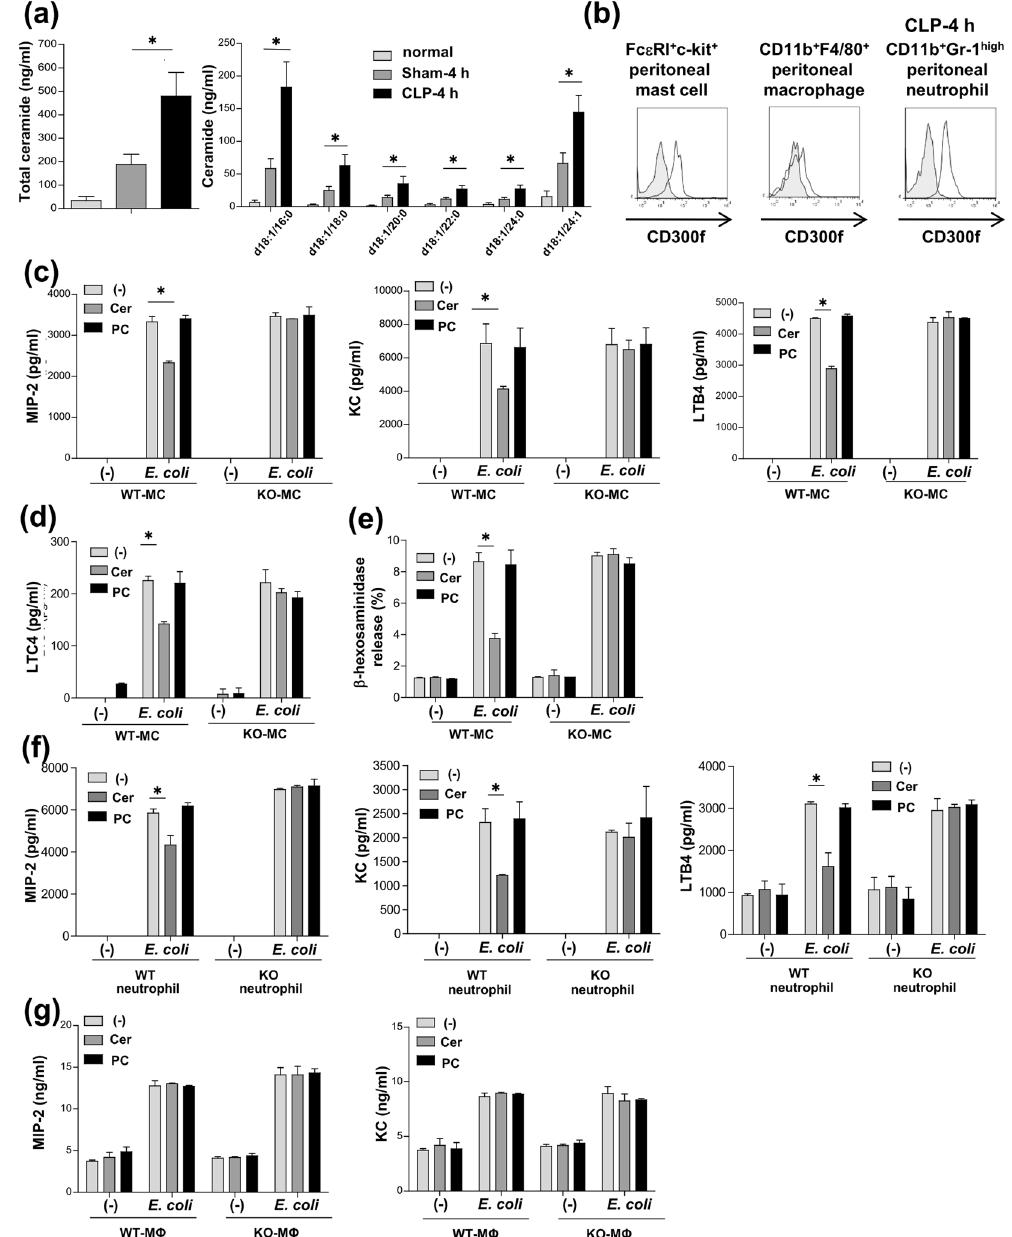
Figure 3. Ceramide-CD300f interaction suppressed the release of factors (inducing neutrophil migration) from mast cells and neutrophils in response to the presence of E. coli . ( a ) The concentrations of all and indicated ceramide species in PLF before or 4 h after a sham operation or CLP in WT mice (n = 5 per group). ( b ) Surface expression levels of CD300f in peritoneal mast cells (MC) or macrophages (M φ ) before CLP or in neutrophils 4 h after CLP in WT mice. C-G, WT or CD300f − / − BMMCs ( c – e ) neutrophils ( f ), or peritoneal macrophages ( g ) were stimulated with 5 × 10 7 CFU/ml heat-killed E. coli on plates coated with ceramide, PC, or vehicle. Production of ( c , f ) MIP2, KC, and LTB4, ( d ) LTC4, ( e ) a release of β -hexosaminidase, or ( f ) MIP2 and KC. ( b – g ) The data are representative of four independent experiments. The data are expressed as mean ± SD; * p < 0.01 (Student’s t